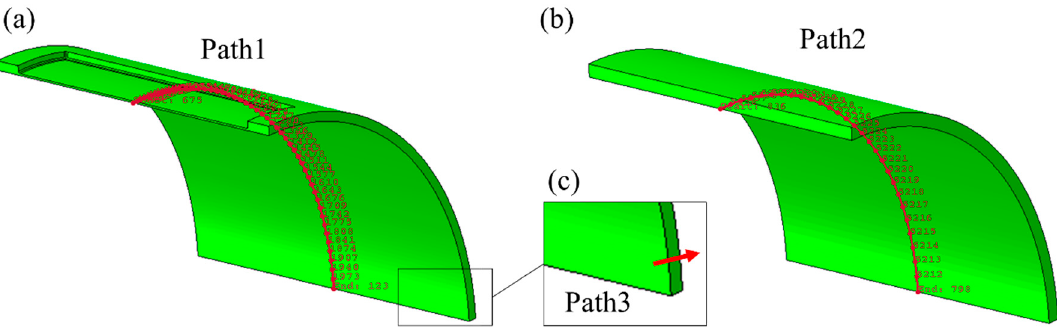
Figure 11. Definition of the three paths along which results were extracted: ( a ) Path1 used for the steel in a repaired section; ( b ) Path2 used for the composite sleeve; ( c ) Path3 along the radial direction through the thickness of an unrepaired section of the pipe.